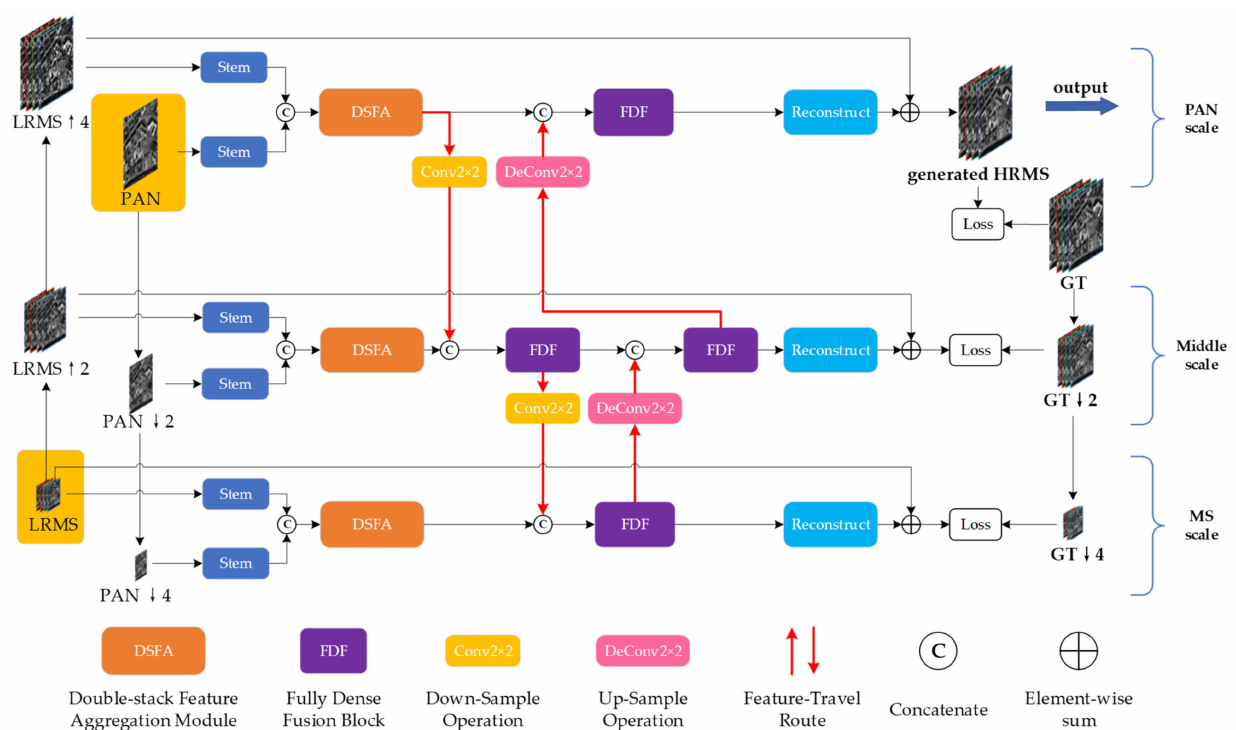
Figure 1. Detailed structure of the proposed double-stack aggregation network using the feature- travel strategy. Gold colour represents the input images (PAN and LRMS